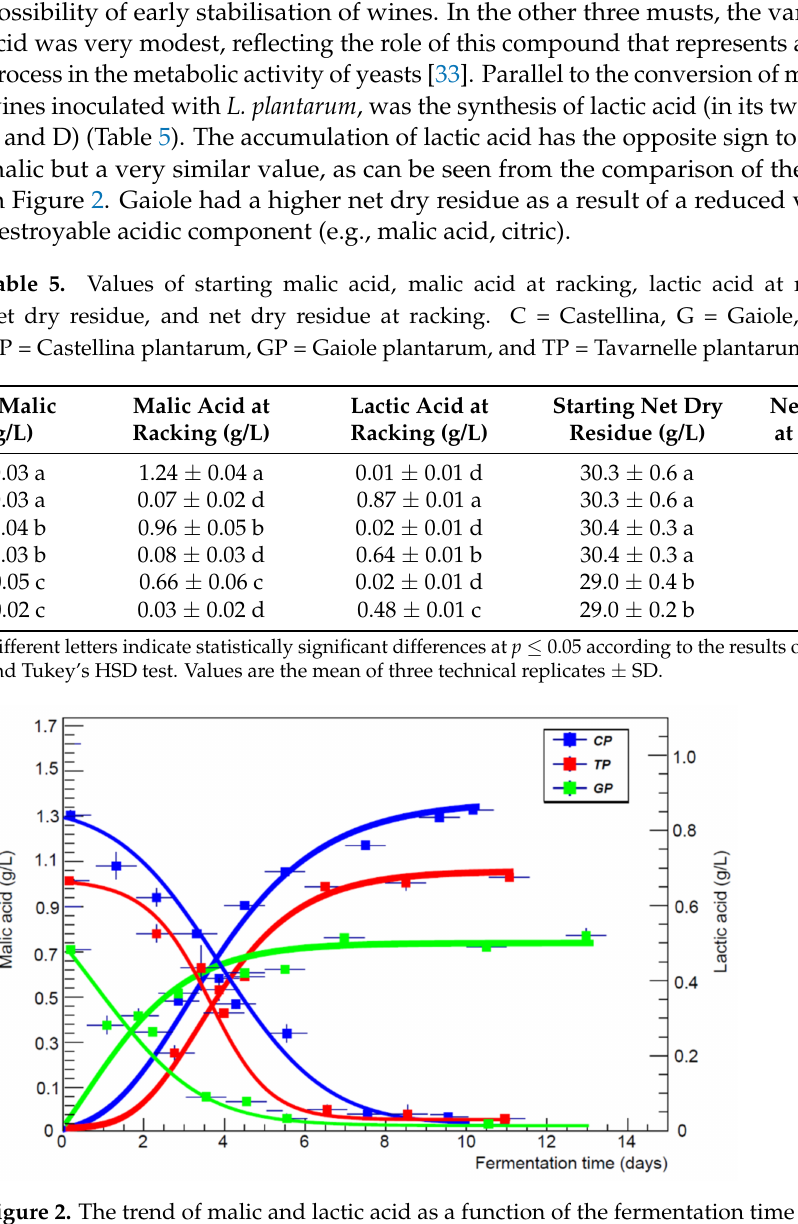
Figure 2. The trend of malic and lactic acid as a function of the fermentation time (days) for all the three plantarum